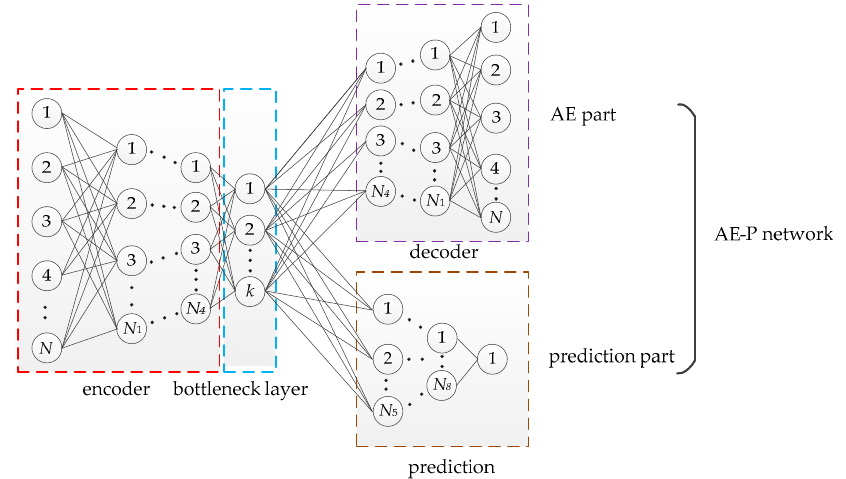
Figure 4. Structure of the designed auto-encoder prediction (AE-P) network.